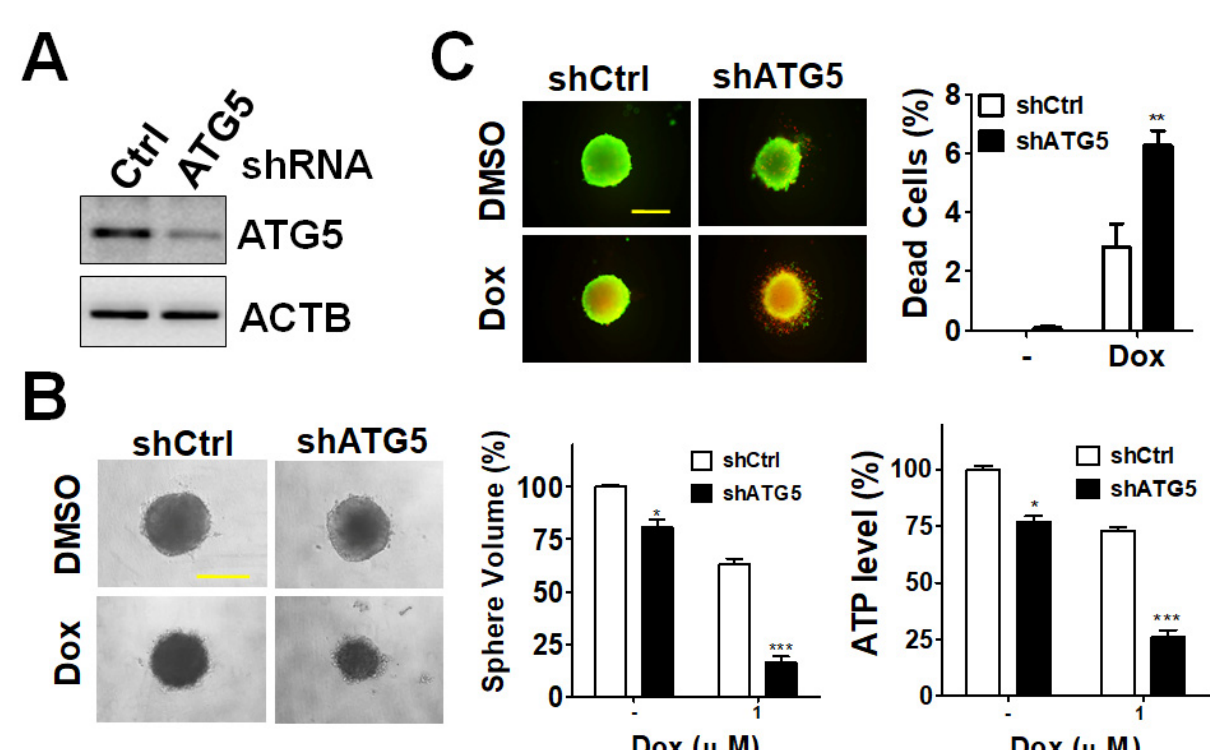
Figure 6. Effects of silencing ATG5 on chemosensitivity in tumorspheres. ( A ) HCT116 cells were transfected with scrambled shRNA or shRNA against ATG5 and selected for stable clones. The knockdown efficiency of ATG5 in HCT116 were confirmed with immunoblotting. ( B ) HCT116 cells carrying scrambled shRNA or shRNA against ATG5 were cultured to form spheres. The tumorspheres were treated with DMSO or Dox (1 µ M) for 48 h to image the spheres. Scale bar: 400 µ m (left panel). HCT116 spheroid cells were lysed to assess cell viability (right panel). ( C ) The tumorspheres were treated with Dox (1 µ M) for 48 h. The viable (green) and dead (red) spheres were observed under fluorescent microscope. The quantified results are expressed as the mean ± SEM from three independent experiments (n = 6). * p < 0.05, ** p < 0.01, *** p < 0.001.